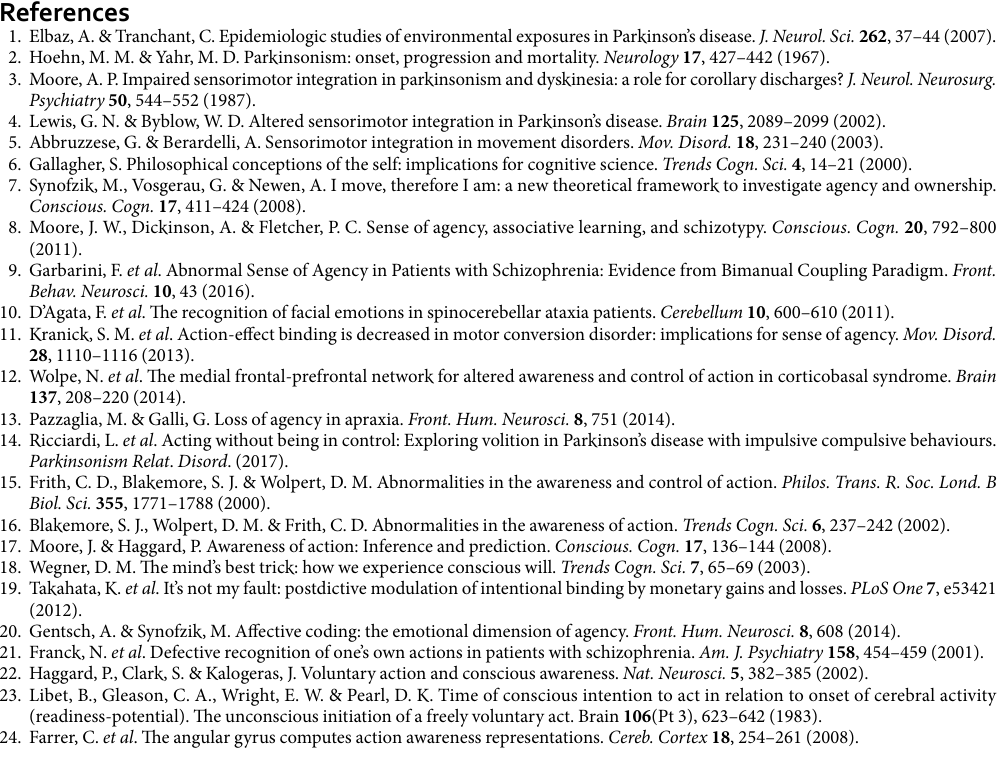
There could potentially be two types of errors in the reaction: “yes” responses for trials with biases, and “no” responses for neutral trials. For data analysis, “yes” responses were focused upon, reflecting the participants’ abil- ity to recognize the movement as their own. The experimental setups are illustrated in Fig. 3. Data analysis. One patient was excluded from the analysis due to a technical failure in presenting the task. The percentage of ‘yes’ responses in the angular biases condition was analyzed by mixed-effect ANOVA, with group (patients versus controls) as between-subject factor, and event (gap of 0°, 5°, 10°, 15°, or 20°) and hand (more-affected versus less-affected in patients, left versus right in controls) as within-subject factor. Next, the percentage of ‘yes’ responses in the temporal biases condition was analyzed by mixed-effect ANOVA, with group (patients versus controls) as between-subject factor, and event (delay of 0, 50, 100, 150, 200, 300, 400, or 500 ms) and hand (more-affected versus less-affected in patients, left versus right in controls) as within-subject factor. Degrees of freedom were adjusted by Greenhouse-Geisser correction. The more-affected hand in patients was matched to the left hand in controls, and the less-affected hand in patients was matched to the right hand in con- trols in the following analysis, for the same reason as in implicit task.